Question: Which visualization type does this figure use?
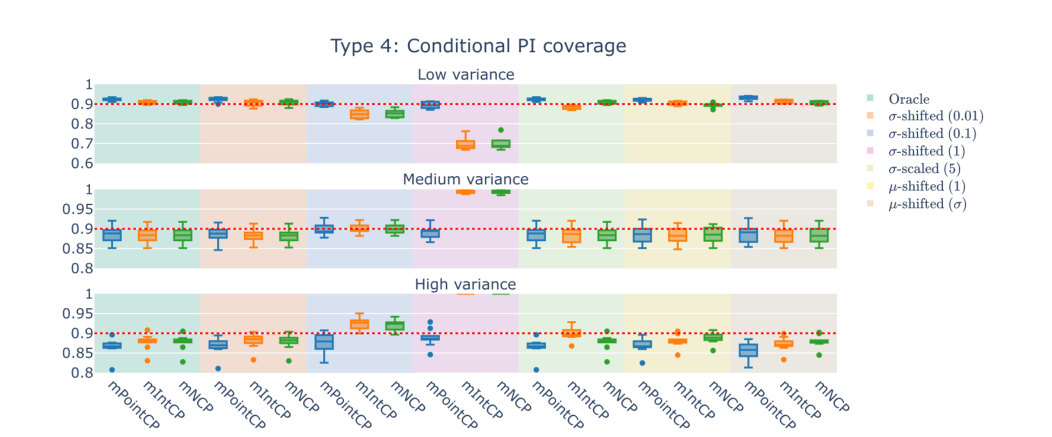
Answer: line